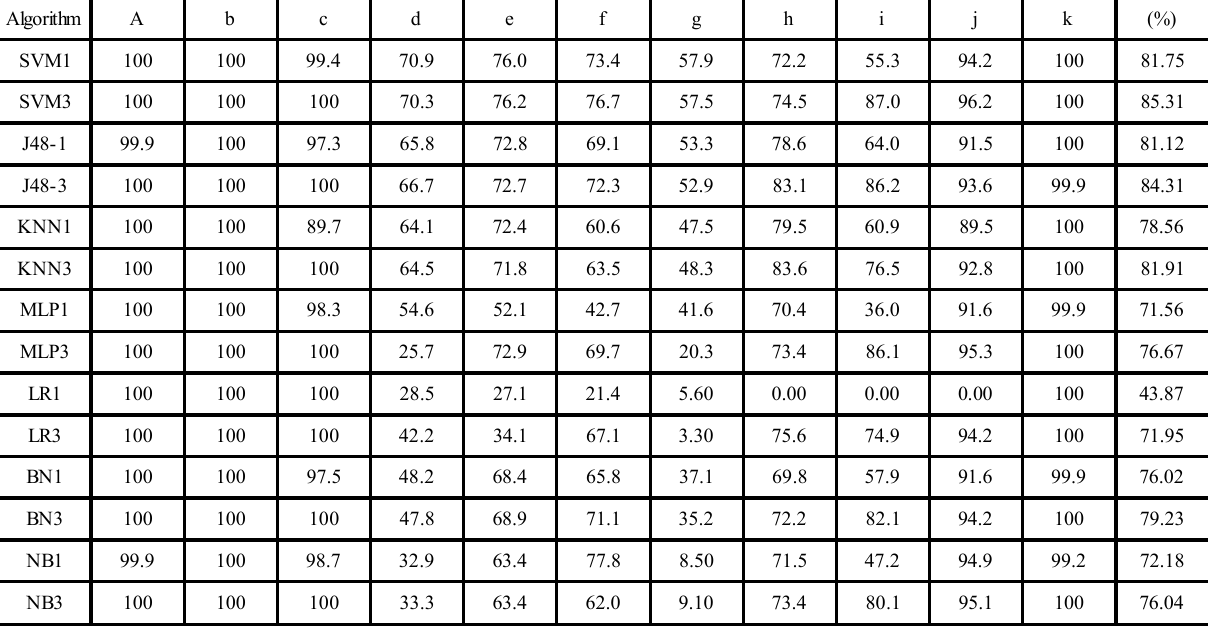
TABLE 3. RECOGNITION ACCURACY COMPARISON, 1 VS. 3 GROUPS OF